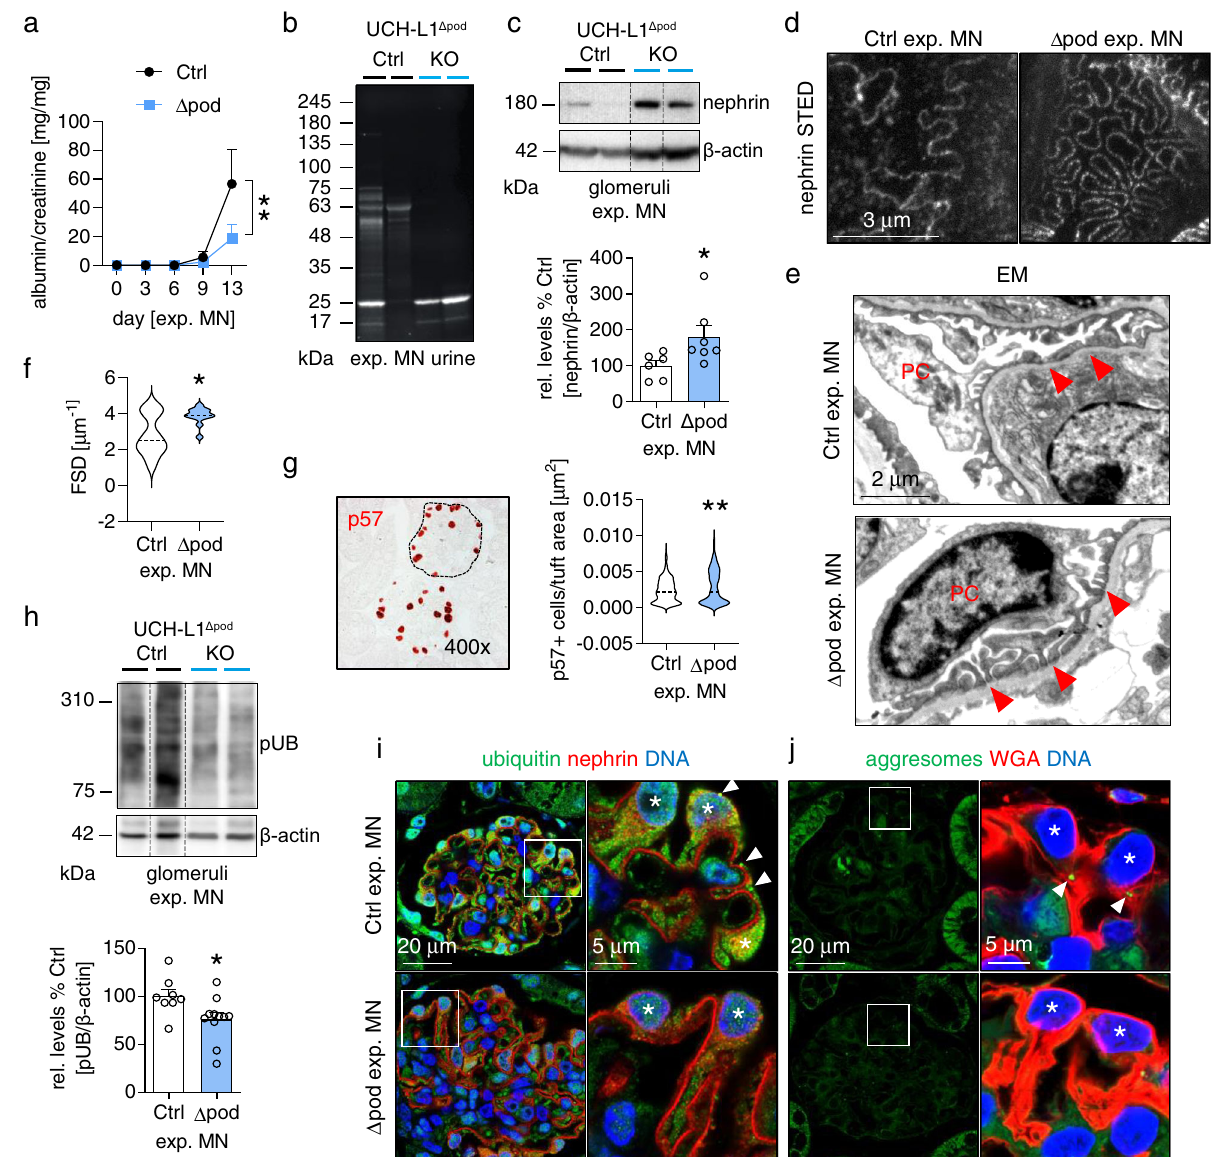
Fig. 5 | Podocyte-speci fi c UCH-L1 deletion attenuates ubiquitin accumulations and podocyte injury in experimental MN. Experimental MN was induced by i.v. injection of AP-abs in UCH-L1-de fi cient ( Δ pod) and littermate (Ctrl) mice. Kidneys were collected on day 14. a Urinary albumin to creatinine ratio. Pooled values of 6 independent experiments, mean+/-SEM, per time n ≤ 15 (Ctrl) or n ≤ 18 ( Δ pod), ** p =0.0022, Two-Way ANOVA. b Stainfree SDS-PAGE from 1 experiment of creatinine-adapted urines depicts loss of high molecular weight proteins in Ctrl mice, albumin ~63 kDa. c Immunoblot quanti fi cation of glomerular nephrin abun- dance normalized to β -actin. Pooled values of 2 independent experiments, mean+/-SEM, n =6 (Ctrl) or n =7 ( Δ pod), * p =0.014, two-tailed Mann Whitney U test. d STED analyses of nephrin meanders. e Electron microscopy (EM) demon- strates effaced foot processesin Ctrlandmostly preserved footprocesses in Δ pod mice, PC=podocyte, red arrowheads = foot processes. f Quanti fi cation of foot processeffacementbyPEMPanalysesof fi ltrationslitdensity(FSD)lengthperarea ( µ m − 1 ), pooled values of 1 experiment, mean+/-SEM, n =15 (Ctrl) or n =12 ( Δ pod), * p =0.0321, two-tailed Mann Whitney U test. g Podocyte number per glomerular